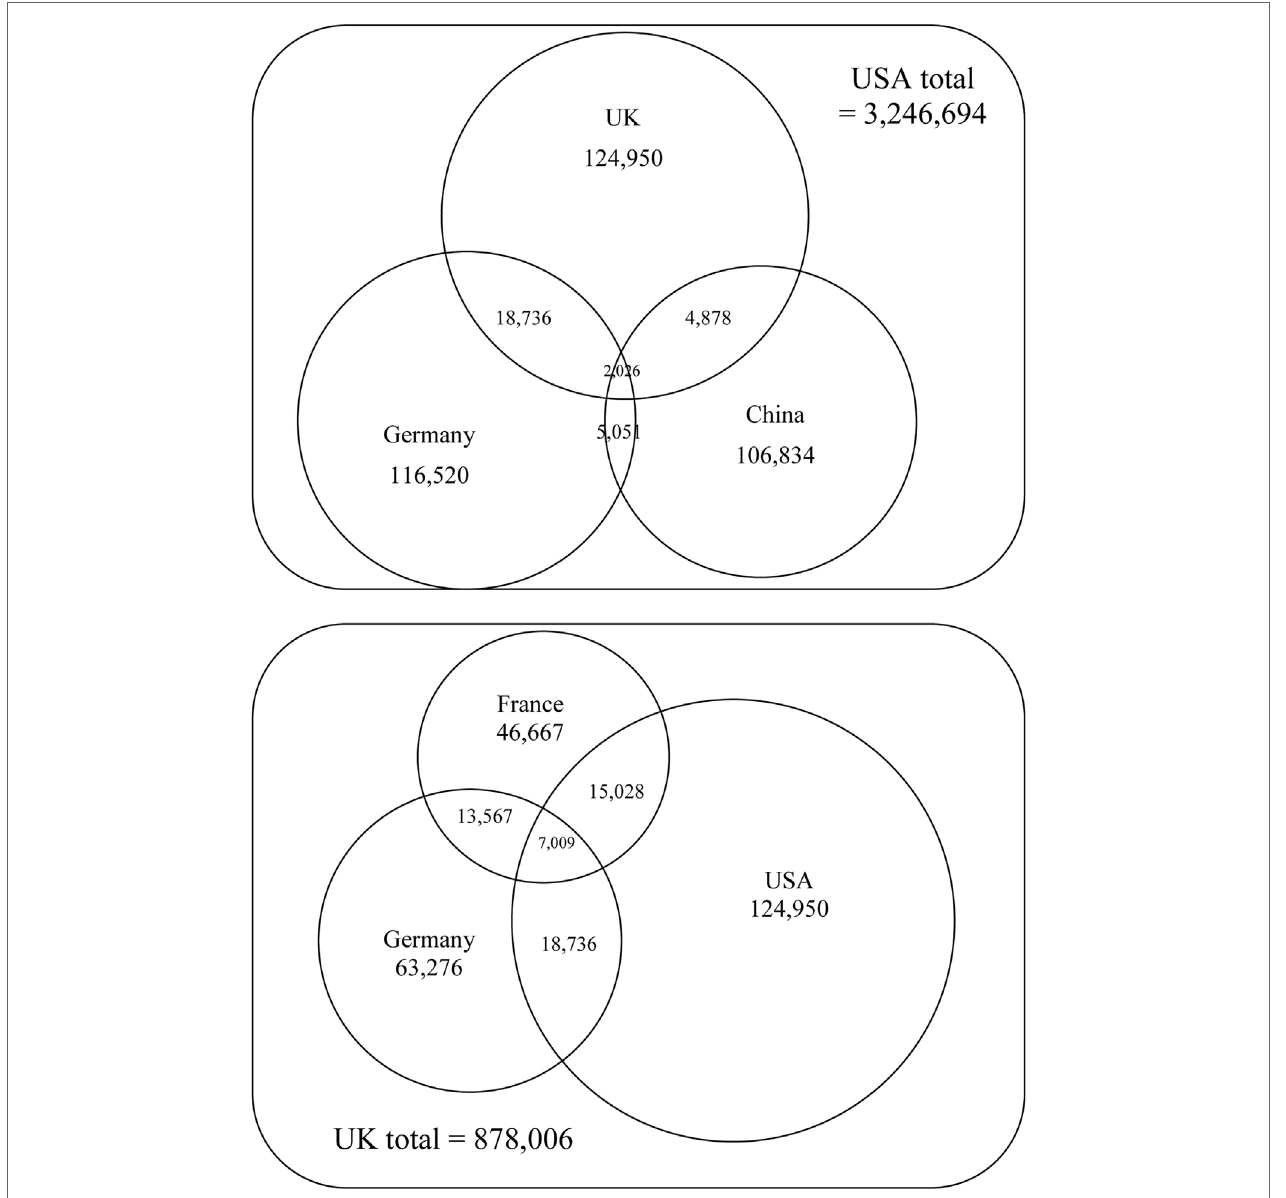
FigUre 3 | International collaboration intersections for the USA and UK, illustrating the relative frequency of bilateral, trilateral, and quadrilateral co-authorship. The figure in the outside box is the total national output for 2002–2011 and the figures in each circle and sector are the numbers of papers for the relevant intersection. For example, the USA published over three million papers of which 124,950 had a UK co-author. Of those, 4,878 also had China as a third author, and of those 2,026 had a fourth German